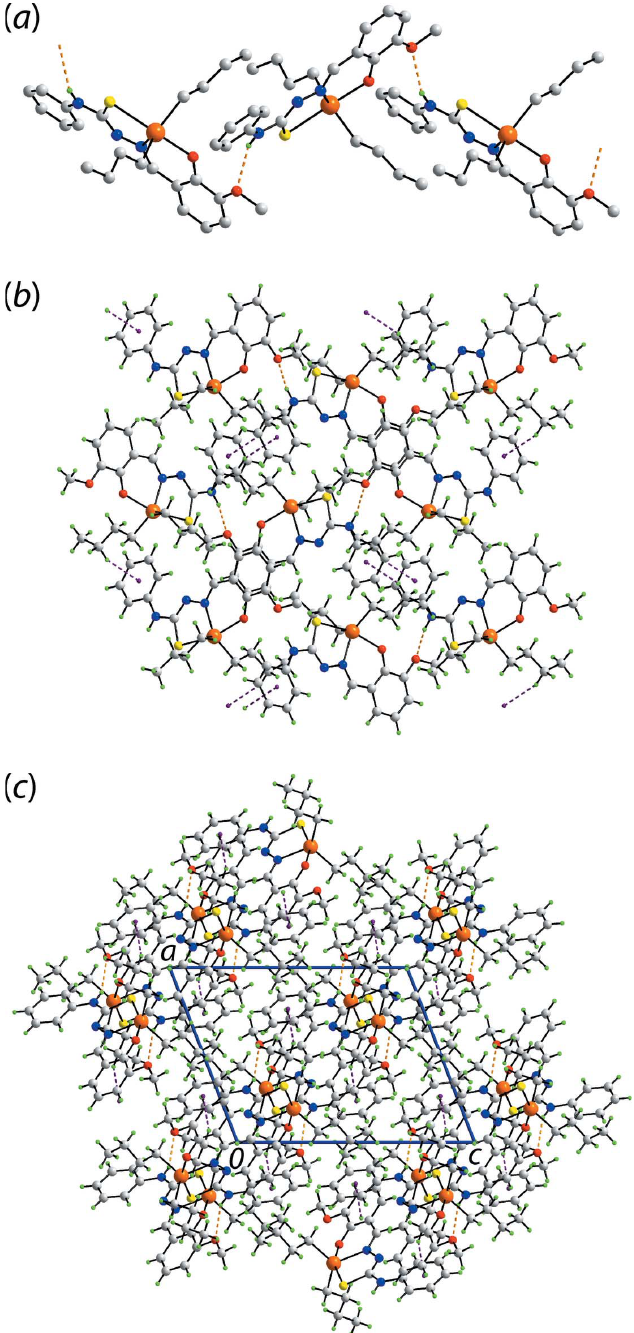
Figure 2 Molecular packing in (I): ( a ) the helical, supramolecular chain sustained by amine- N — H (cid:2)(cid:2)(cid:2) O (methoxy) hydrogen bonding shown as orange dashed lines (non-participating H atoms omitted), ( b ) the supramolecular layer parallel to ( 101) whereby the chains of ( a ) are connected by methylene-C—H (cid:2)(cid:2)(cid:2) (cid:2) (phenyl) interactions shown as purple dashed lines and ( c ) a view of the unit-cell contents shown in projection down the b - axis